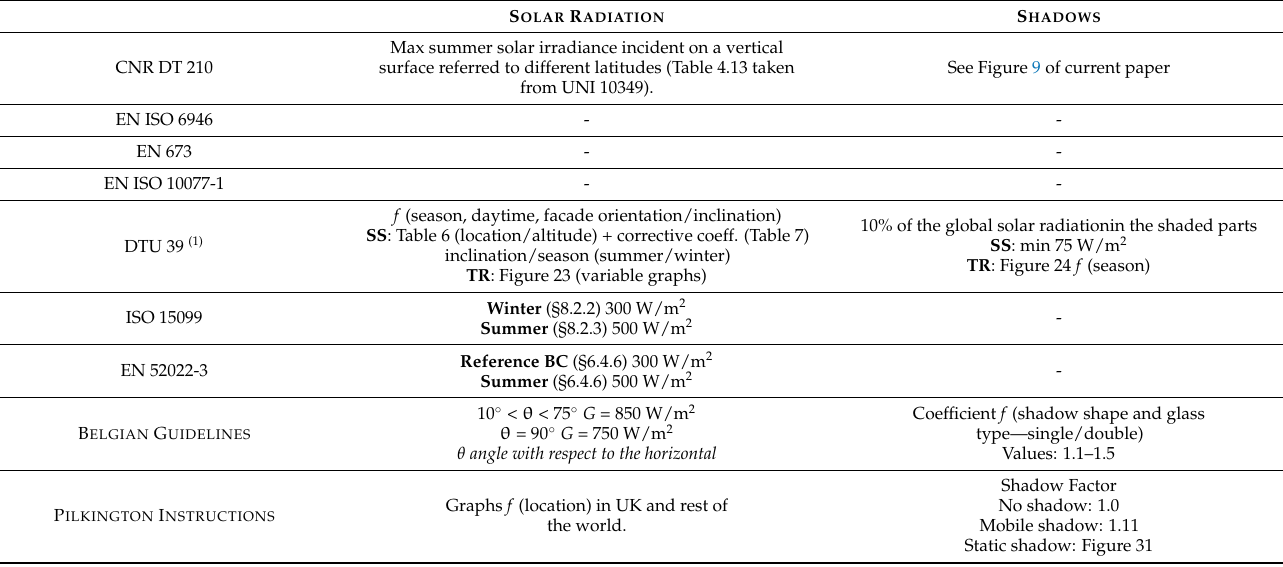
Graphs f (location) in UK and rest of the world.